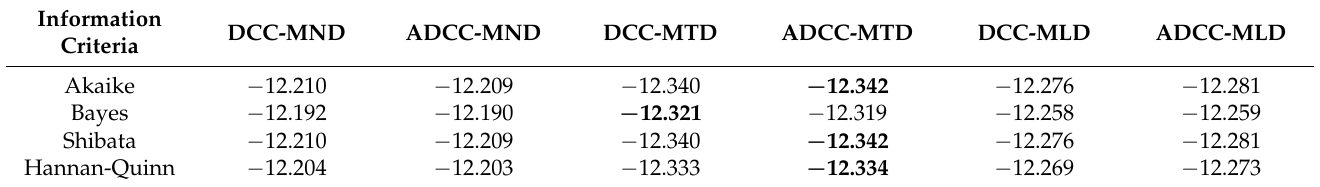
Table 2. Information criteria of (A)DCC-GARCH models for SHCI and SP500 pair.